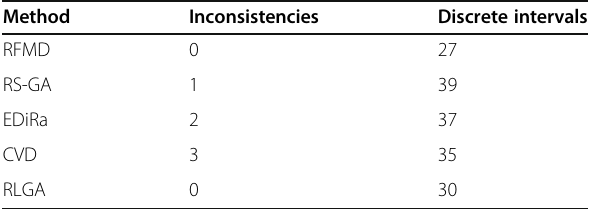
Table 8 Number of data errors in the second methylation dataset